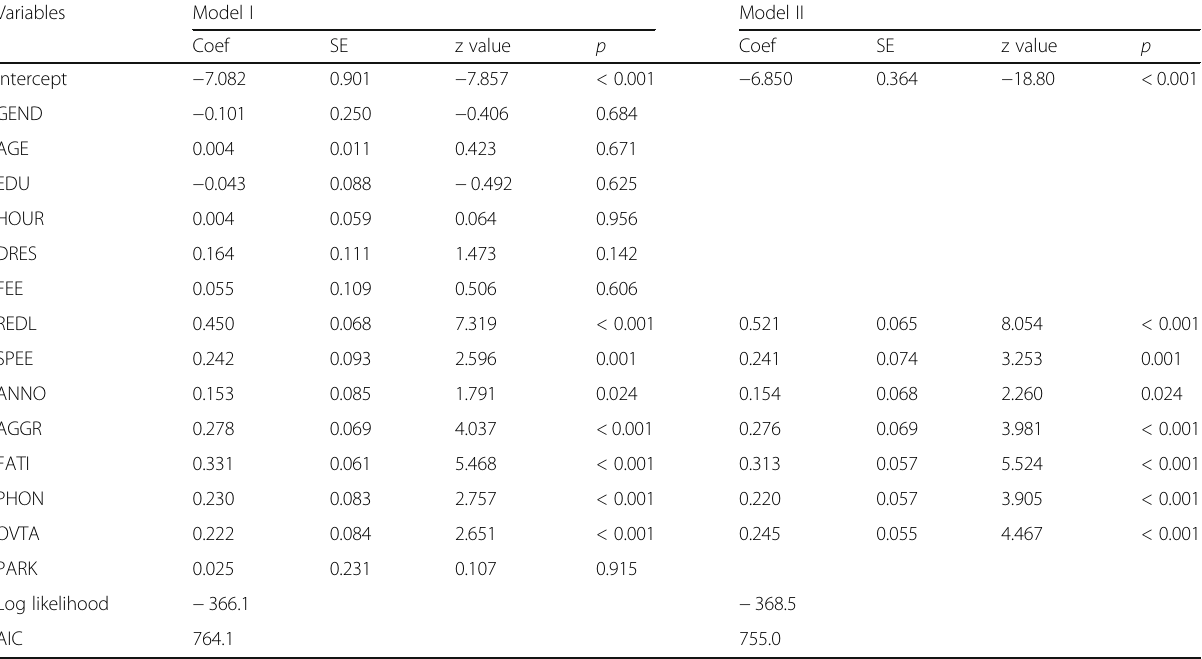
Table 3 Negative Binomial Model estimation of PIN crash risk among taxi drivers